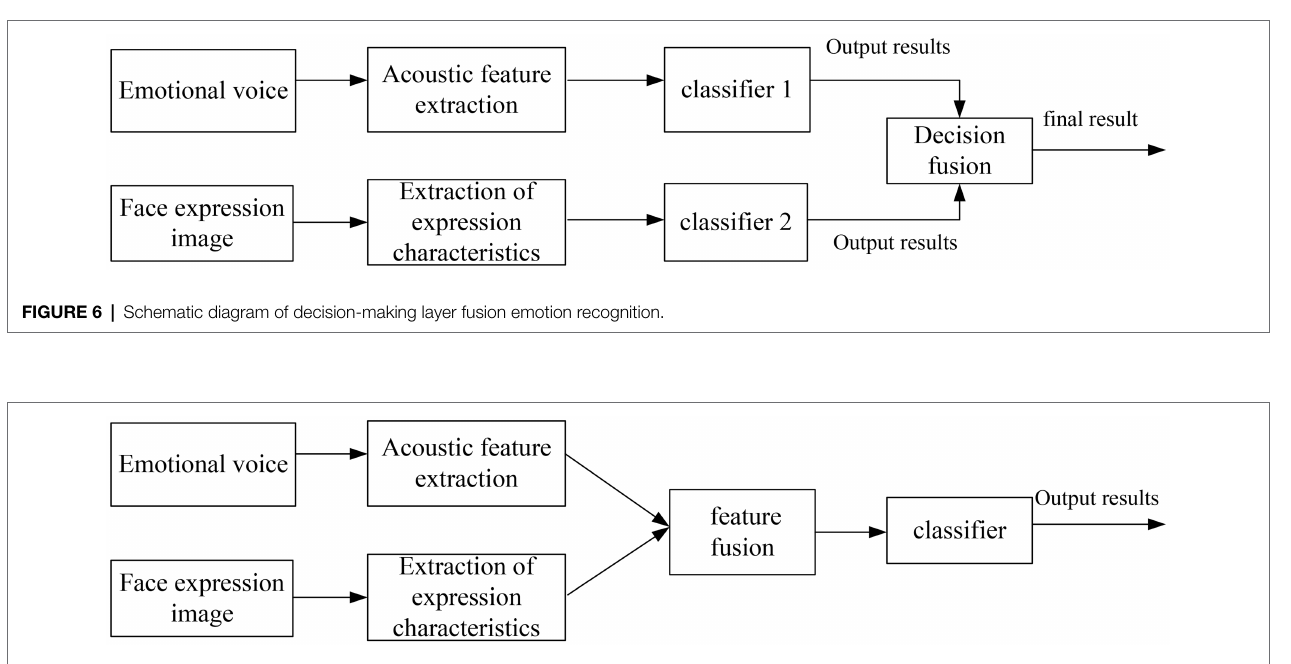
FIGURE 7 | Schematic diagram of feature layer fusion emotion recognition.